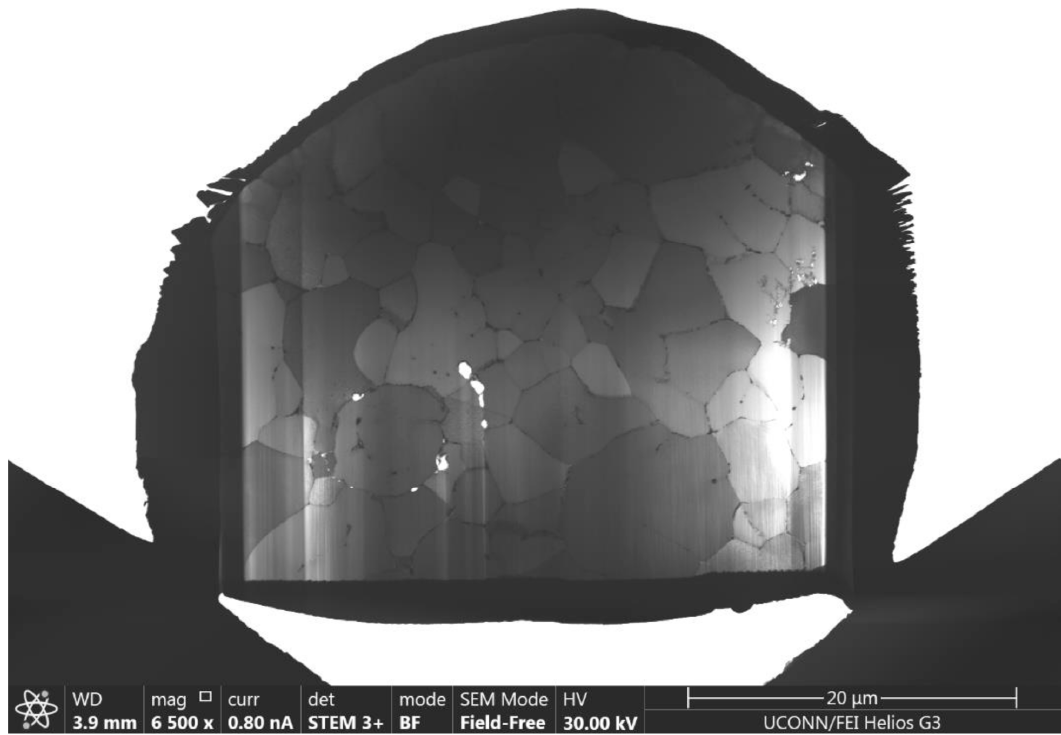
Figure 5. STEM micrograph of an as-atomized Al 6061 powder particle (with an approximately 47 μ m diameter), prepared for STEM-based characterization via FIB